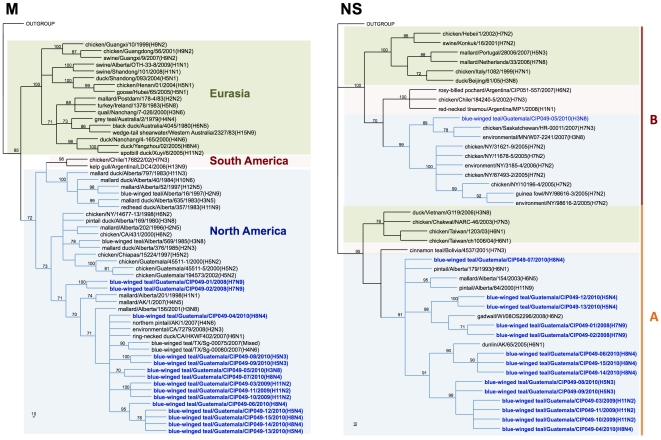
Phylogenetic trees for internal gene segments NP, M and NS.All trees were generated in PAUP 4.0b10 using Neighbor-Joining method with 1000 bootstrap replicates (bootstrap values above 70% are shown). Scale bar on the bottom-left indicates number of nucleotide substitutions per site.